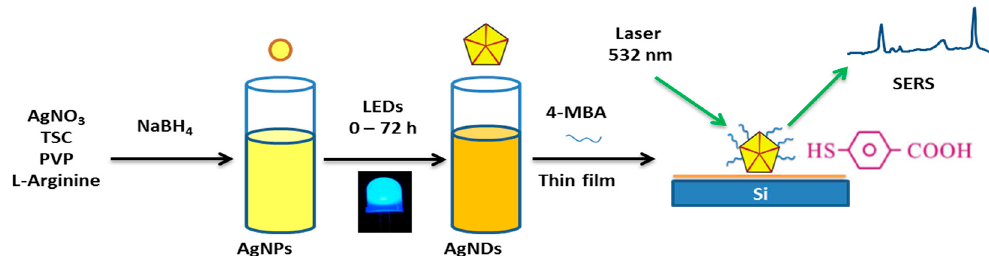
Figure 1. Schematic illustration of the fabrication and surface-enhanced Raman scattering (SERS) measurement of nanodecahedrons (AgNDs). TSC: trisodium citrate tribasic dihydrate, PVP: polyvinylpyrrolidone, AgNPs: silver nanoplates, LEDs: light-emitting diodes, 4-MBA: 4-mercapto benzoic